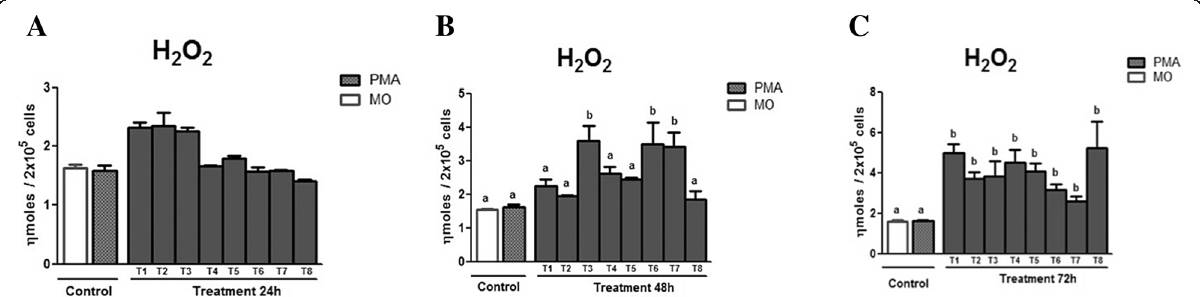
Fig. 7 Means± standard deviation of the mean ( p < 0.05) of H 2 O 2 production by peritoneal macrophages of murine macrophages infected by L. (L.n chagasi treated with Cdt peptide fraction, at three different incubation moments: ( a ) 24 h, ( b ) 48 h, and ( c ) 72 h. The control was done without treatment (MO) and with stimulation by PMA. The PLA 2 doses utilized in the treatment (T) were T1 = 100 μ g/mL; T2 = 50 μ g/mL; T3 = 25 μ g/mL; T4 = 12.5 μ g/mL; T5 = 6.25 μ g/mL; T6 = 3.125 μ g/mL; T7 = 1.5625 μ g/mL; T8 = 0.78125 μ